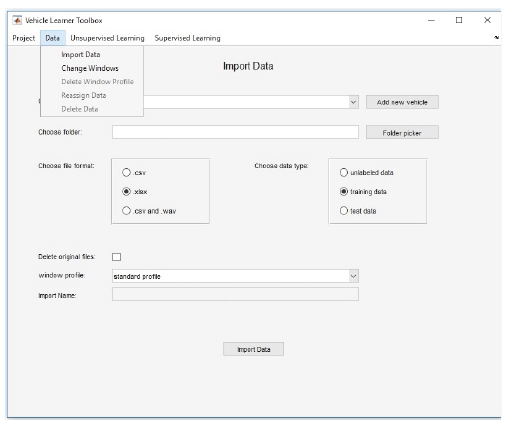
Figure 3: The import data frame of the Vehicle Learner Toolbox . Different vehicles can be chosen and the data type can be set.